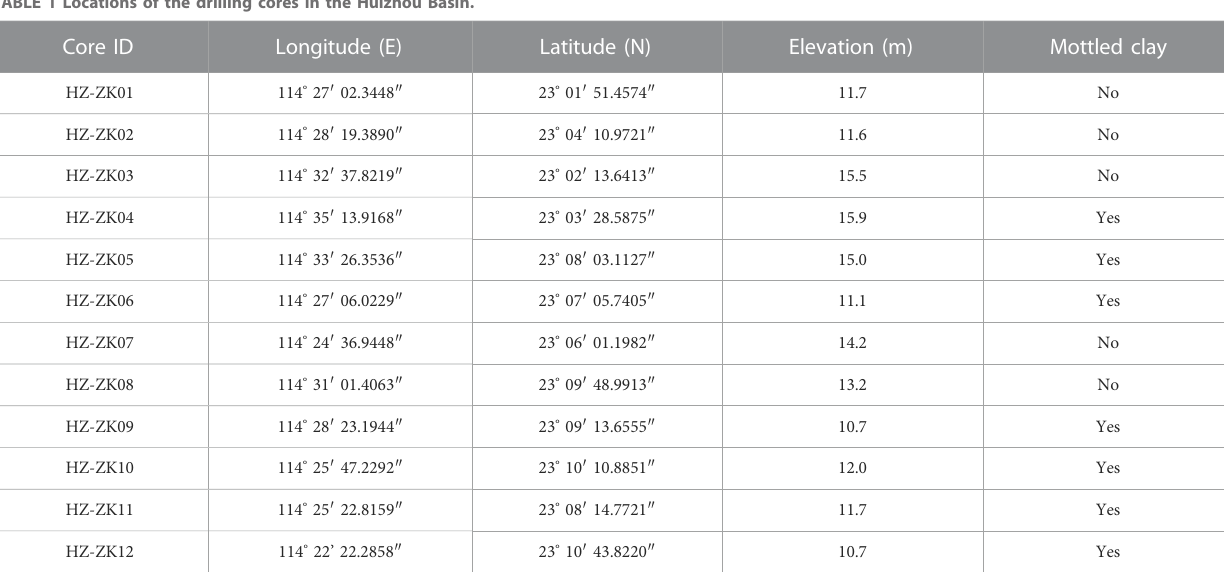
TABLE 1 Locations of the drilling cores in the Huizhou